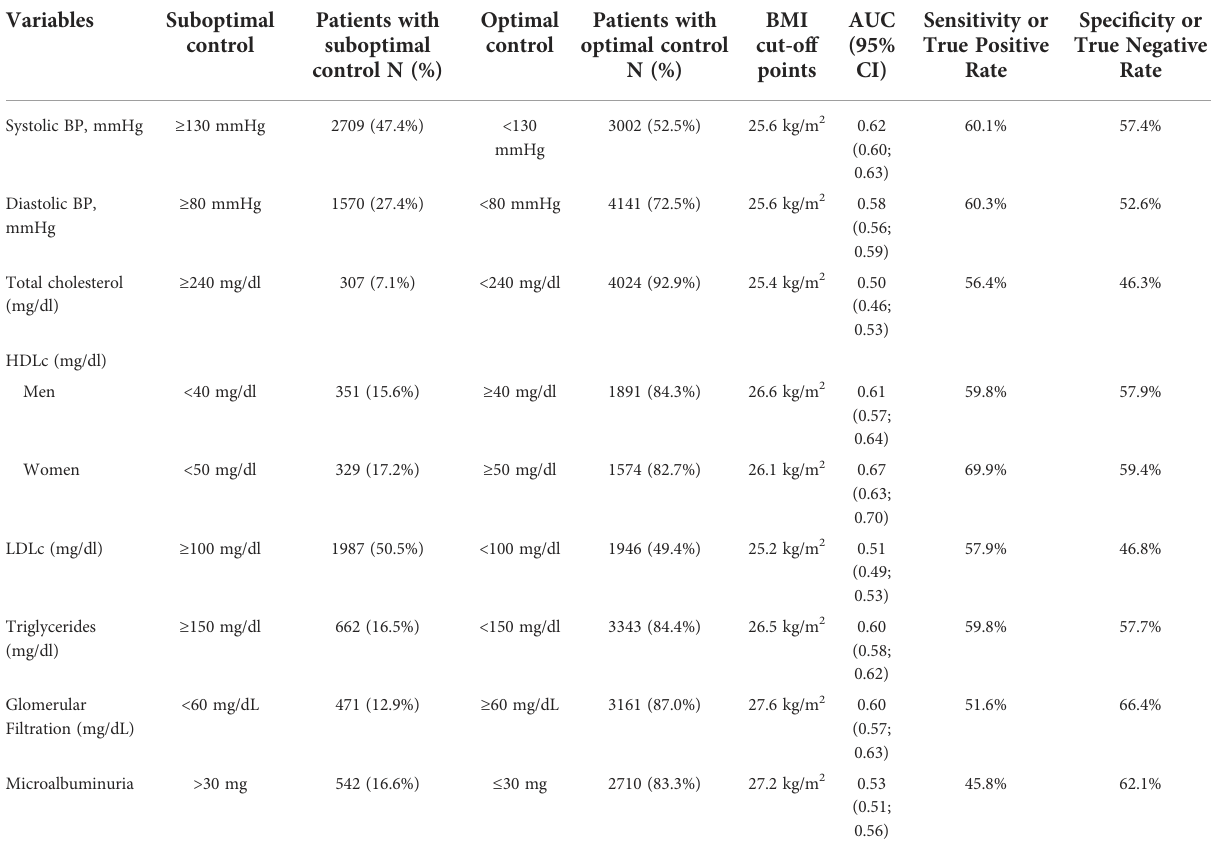
TABLE 4 Cut-off points of the body mass index that show optimal or suboptimal control according to clinical